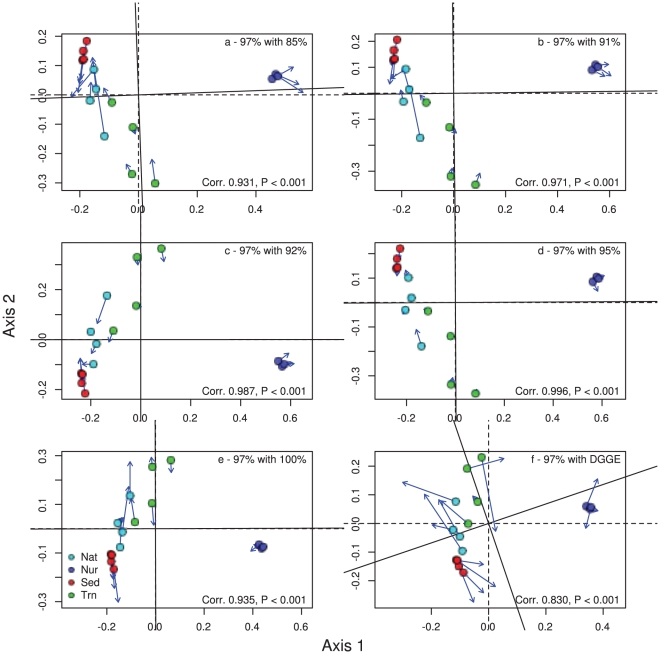
Ordination showing the first two PCO axes of the all bacteria analysis for a) 85% cut-off level with 97%, b) 91% cut-off level with 97%, c) 92% cut-off level with 97%, d) 95% cut-off level with 97%, e) 100% cut-off level and f) DGEE data with 97% cut-off level.The arrows in the ordination point to the target configuration, the actual symbols represent the rotated configuration, i.e., the ordination based on the 97% cut-off values. Correlation (Corr) and significance values are given in the lower right corner of each graph. Both target and original rotated axes are shown as crosshairs on the plot using unbroken and dashed lines.